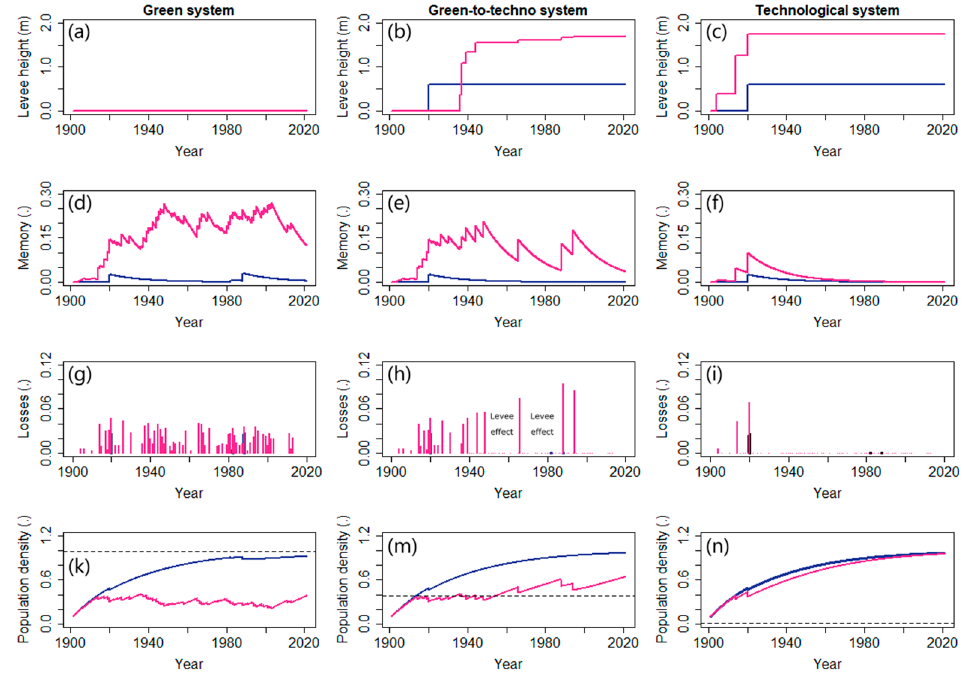
Figure 5. Levee height ( H ), collective memory ( M ), flood losses ( FD ), and population density ( D ) dynamics of green ( a , d , g , k ), green-to-techno ( b , e , h , m ), and technological ( c , f , i , n ) systems for values of the level of bias β equal to 1 (blue) and 10 (magenta). Dashed lines indicate the values of the δ D parameter.